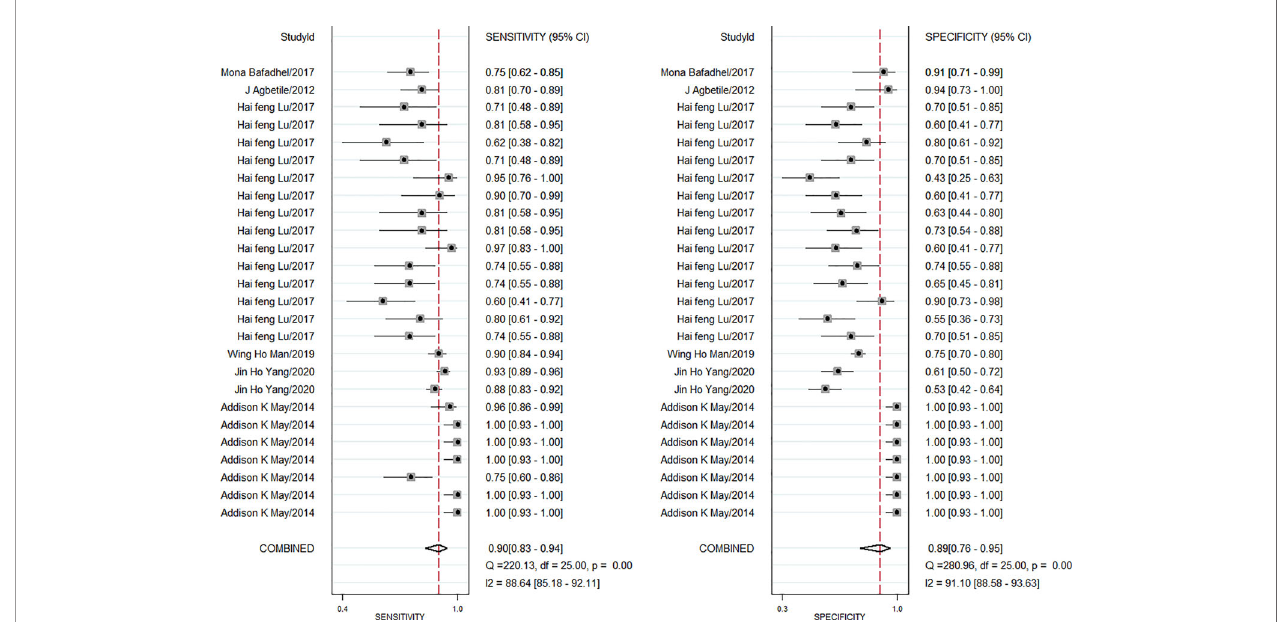
FIGURE 2 | Forest plot of sensitivity and speci fi city of microbiota biomarkers for the diagnosis of lung